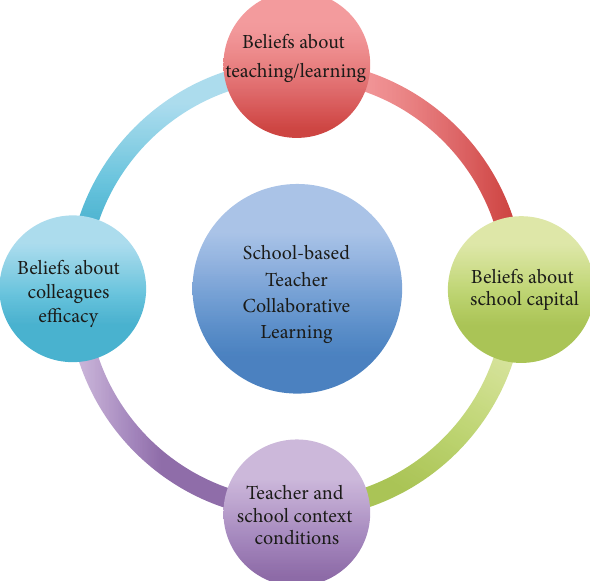
Figure 1: Central concepts and relations guiding the